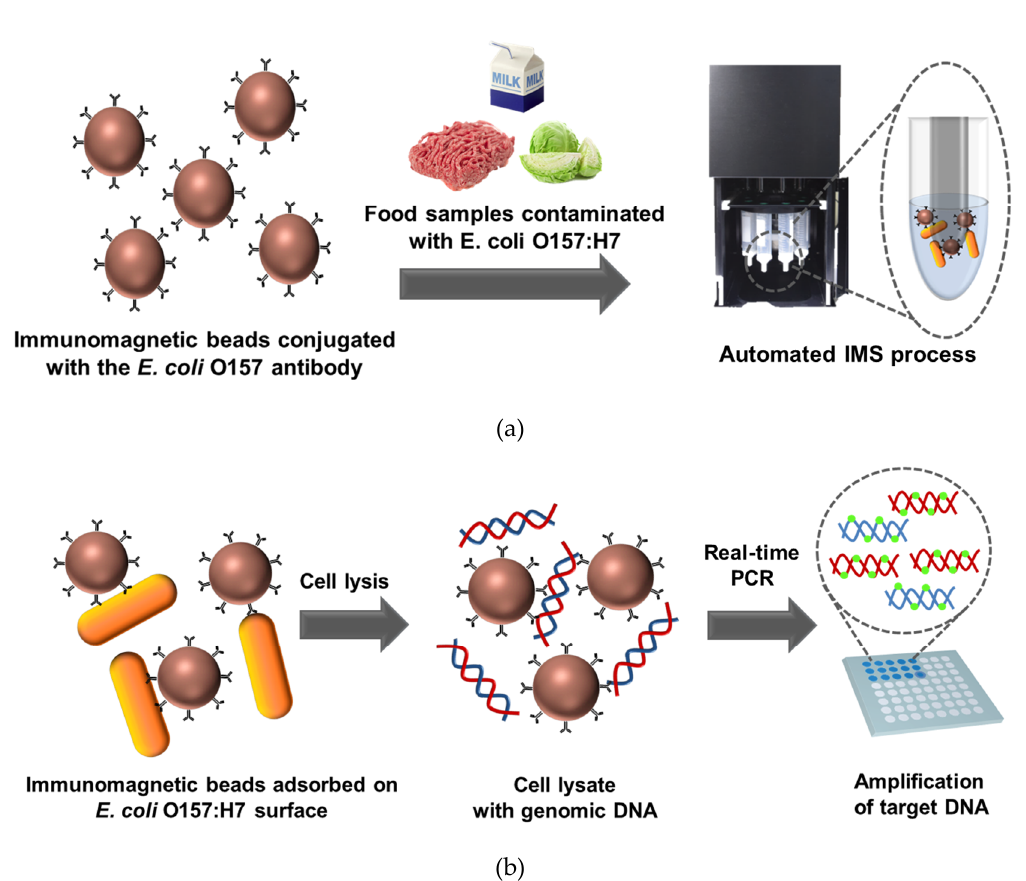
Figure 3. Schematic illustration of the detection method for E. coli O157:H7 using the automated IMS device combined with real-time polymerase chain reaction (PCR): ( a ) The IMS process was used for recovering target bacteria from food samples, in which the target bacteria found in a large volume of food were separated and concentrated into a small-volume chamber; ( b ) the recovered bacteria conjugated with immunomagnetic beads were lysed by heating. After separating the magnetic beads using an external magnetic field, the desired target genomic DNA was obtained, amplified, and detected by real-time PCR.